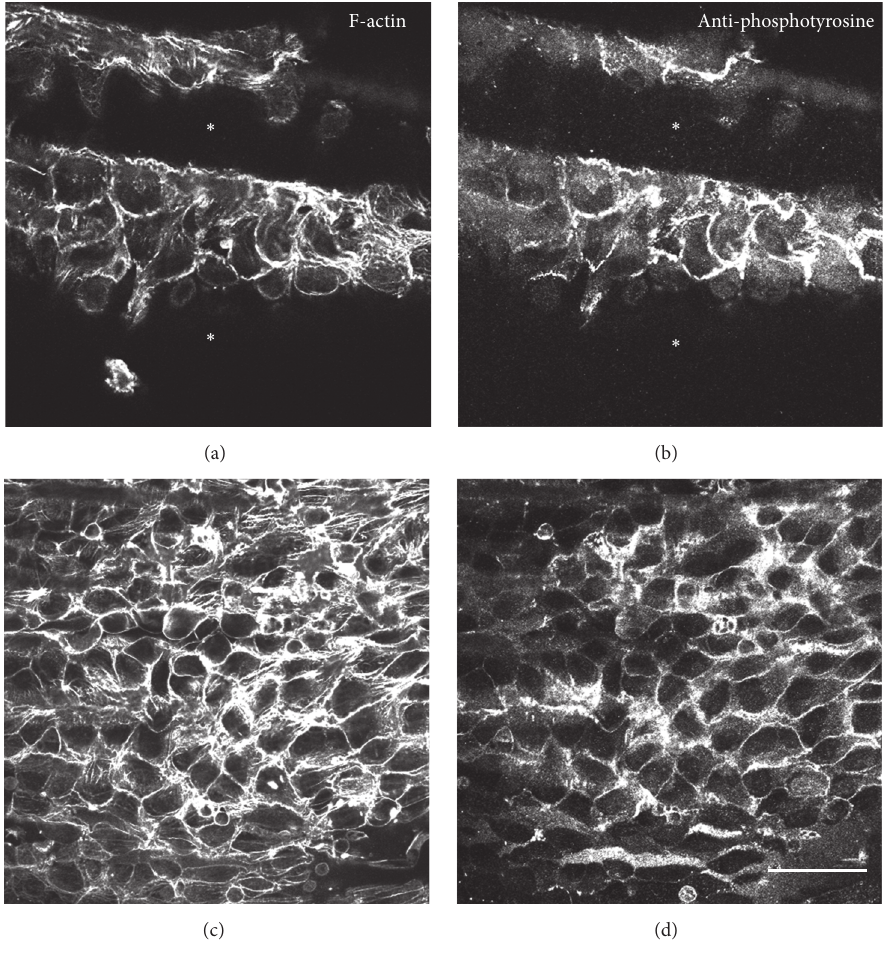
Figure 1: Comparison between conventional fixation (a and b) and microwave irradiation (c and d) of guinea pig aortic endothelial cells in whole-mount preparations. Conventionally fixed specimens showed shrinkage in the smooth muscle cell layer. Asterisks in (a) and (b) indicate gutters caused by shrinkage of the smooth muscle cell layer. Fixation with microwave irradiation showed well-preserved and flattened morphology of the endothelium (c and d). Samples were stained with both anti-phosphotyrosine antibody to reveal tyrosine-phosphorylated proteins (b and d) and rhodamine-labeled phalloidin for F-actin staining (a and c). Samples were observed by confocal laser scanning microscopy, and focus was adjusted at the endothelial cell layer. Bar = 10 𝜇 m. See also